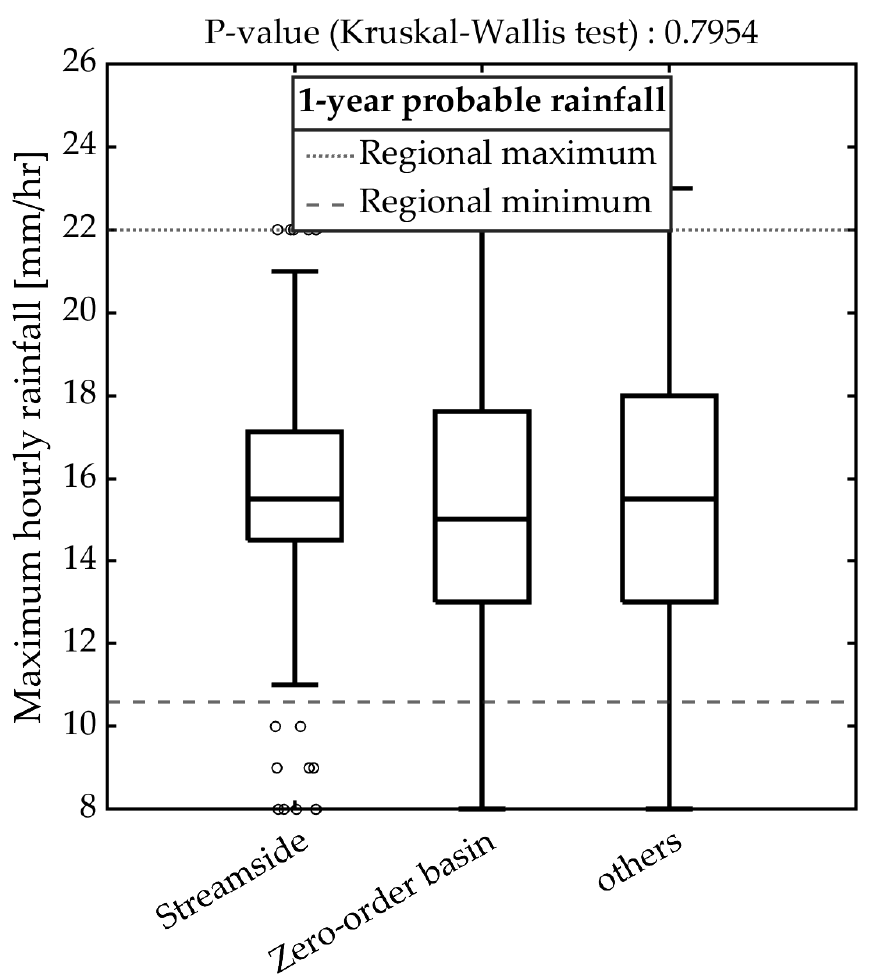
Figure 11. Distribution of maximum hourly rainfall in the damaged area. The line in each box represents the median of the sample; the upper and lower ends of each box represent the upper and lower quartiles, respectively.